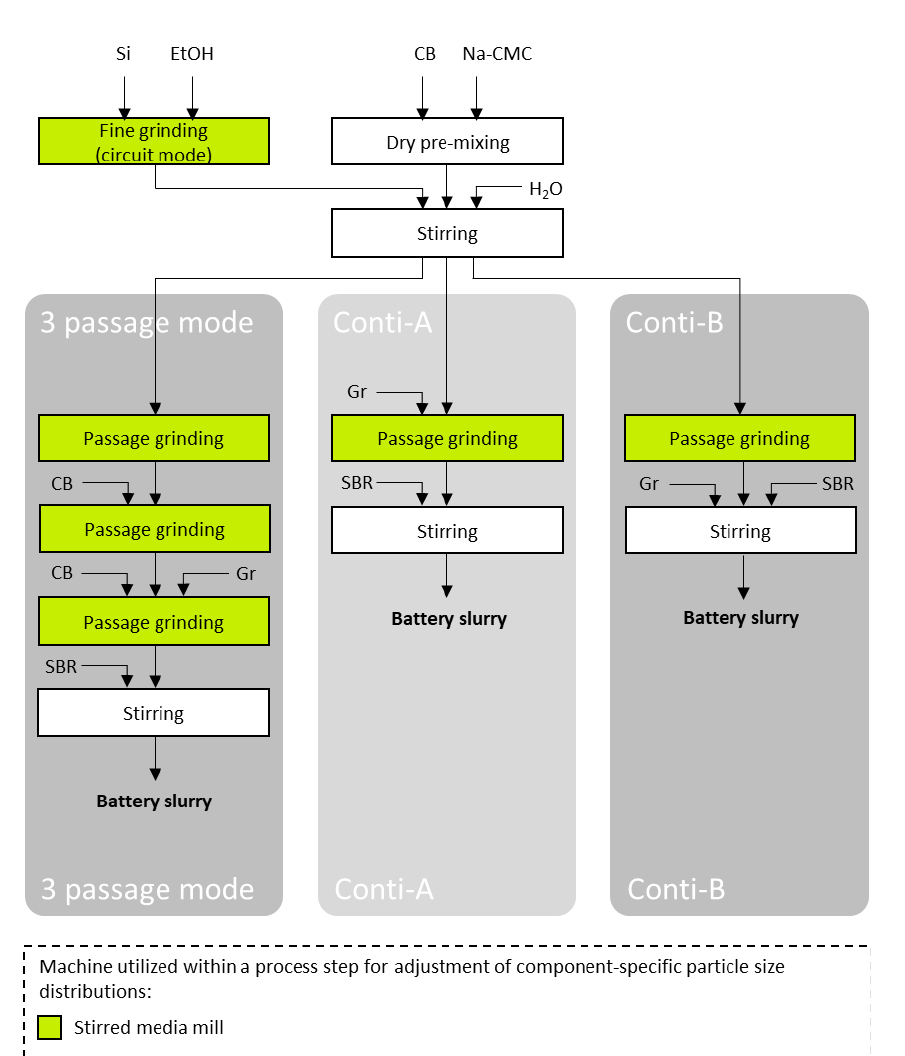
Figure 5. Process scheme for the production of battery slurries using the three different process routes: 3 passage mode, Conti-A, and Conti-B, based on a multicomponent comminution strategy within a stirred media mill.